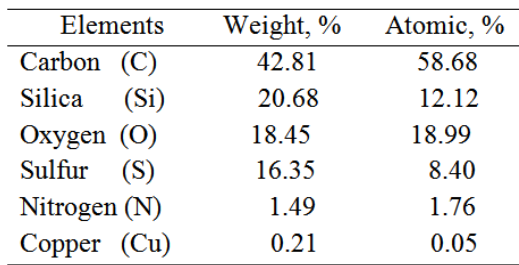
Table 2. EDS composition of PSTM-3T after adsorbed